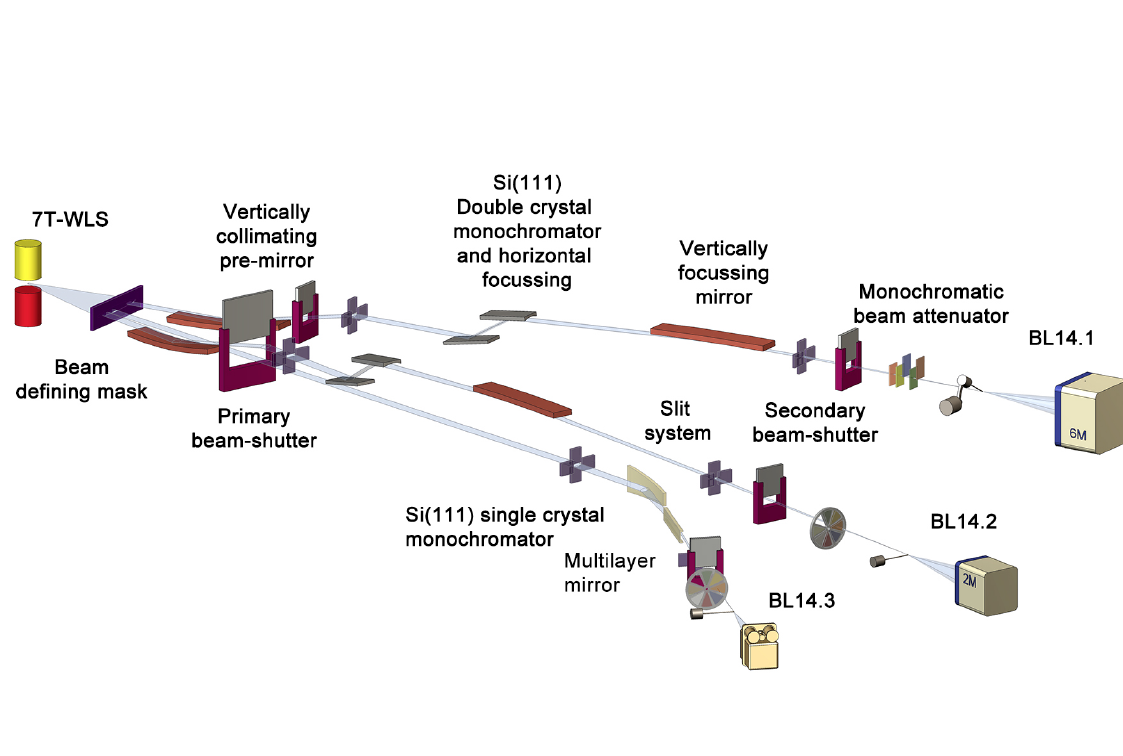
Figure 4: Optical layout of the HZB-MX-beam lines BL14.1-3.